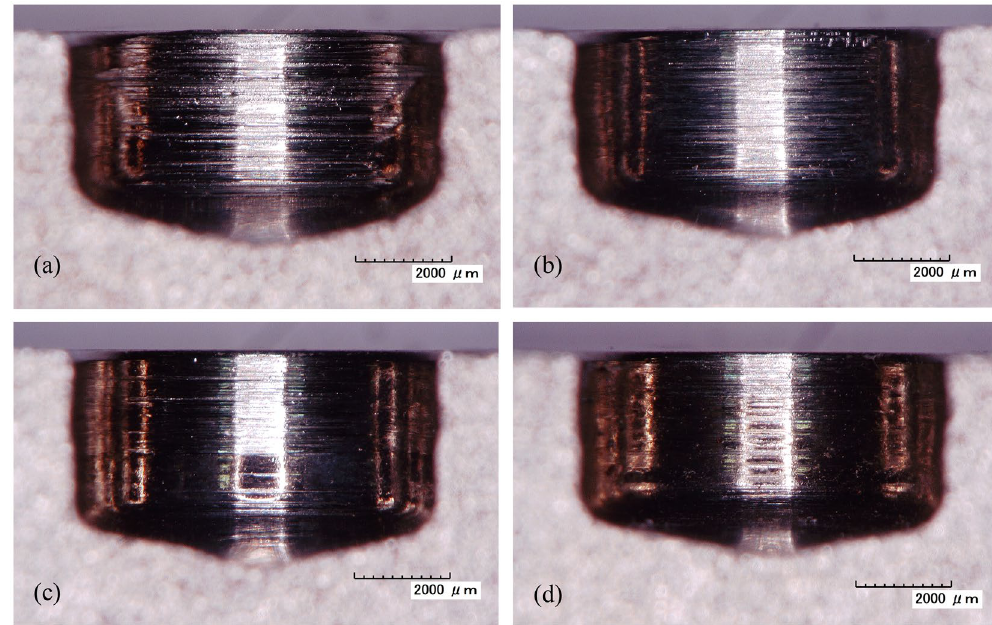
Figure 8. Cross-sections of machined slots for different diamond grain sizes: ( a ) 90#, 1.0 mm min − 1 ; ( b )